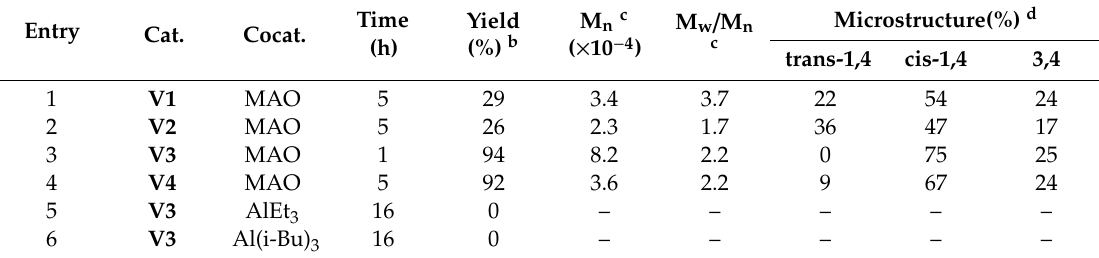
(Table 2, entry 3). The GPC results of the obtained polymers displayed unimodal curves, which indicated single-site active species (Figure 2). Table 2. E ff ects of catalyst and cocatalyst by iminopyridine vanadium complexes a .